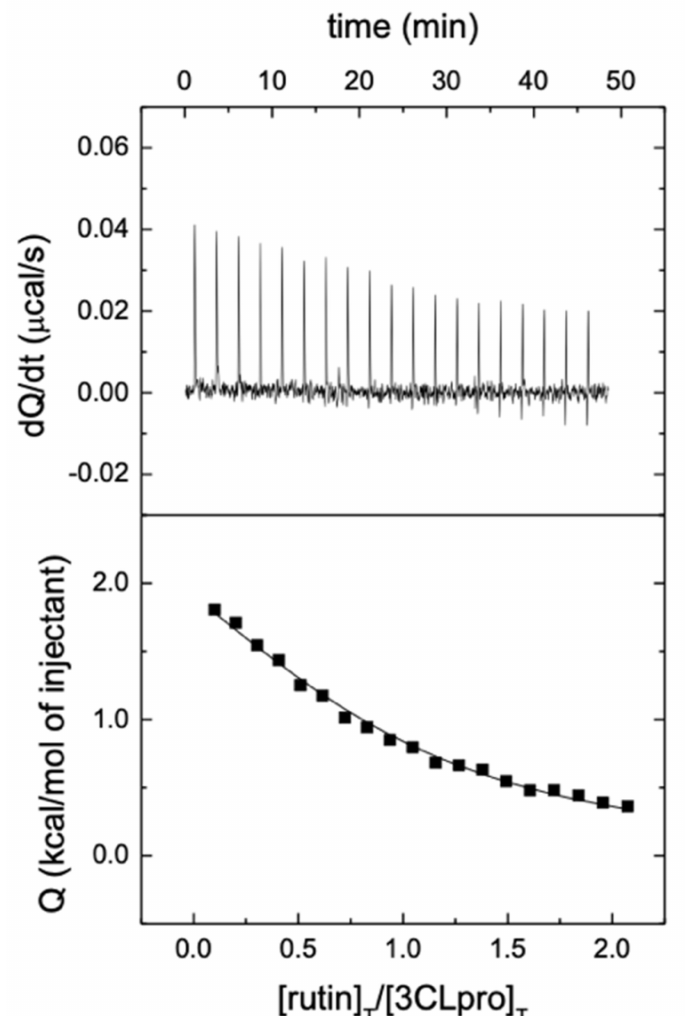
Figure 4. Interaction of rutin with 3CLpro assessed by isothermal titration calorimetry at 25 ◦ C in Tris buffer, pH 7. The upper plot shows the thermogram (thermal power required to maintain a null temperature difference between sample and reference cells as a function of time) and the lower plot shows the binding isotherm (ligand-normalized heat effect per injection as a function of the molar ratio, the quotient between the ligand and protein concentrations in the cell). The fitting curve corresponds to the single ligand binding site model (continuous line). According to the data analysis, rutin interacts with 3CLpro with unfavorable enthalpic contribution ( ∆ H = 3.4 kcal/mol) and favorable entropic contribution ( − T ∆ S = − 10.4 kcal/mol) to the Gibbs energy of binding ( ∆ G = − 7.0 kcal/mol), corresponding to a dissociation constant K d of 6.9 µ M. The fraction of active (or binding-competent) protein is 85% ( n =